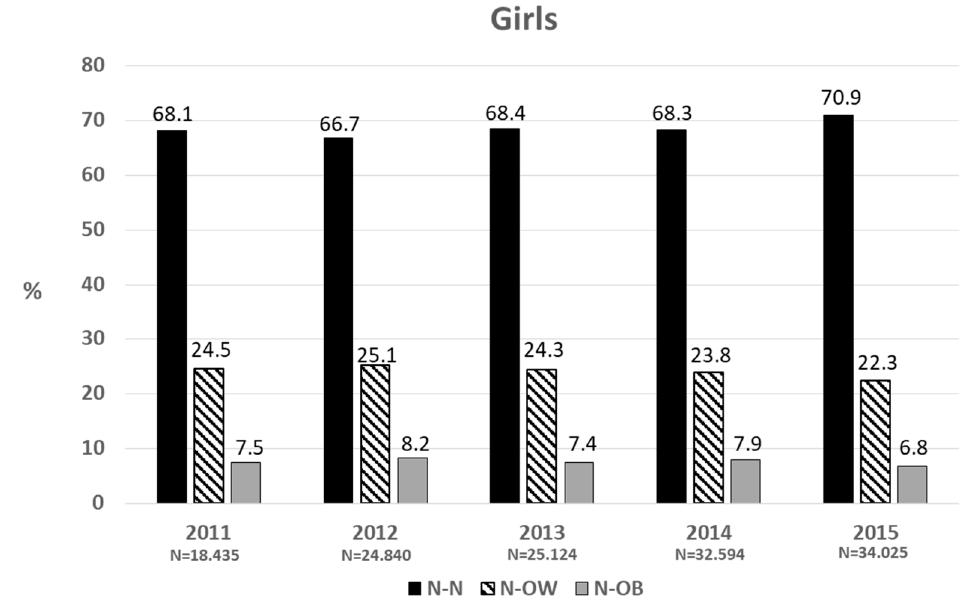
Figure 3. Two-yearchange(inpercentage)inthenutritionalstatusofnormal-weightprekindergartenchildren. Figure 3. Two-year change (in percentage) in the nutritional status of normal-weight prekindergarten children.